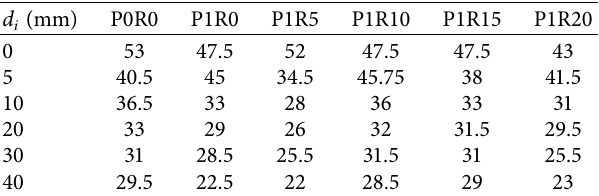
Table 6: Basic frequency of the concrete beam at each damage stage (unit: Hz).